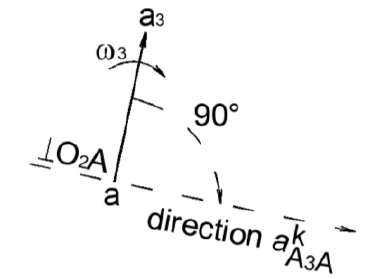
Figure 3. Coriolis acceleration